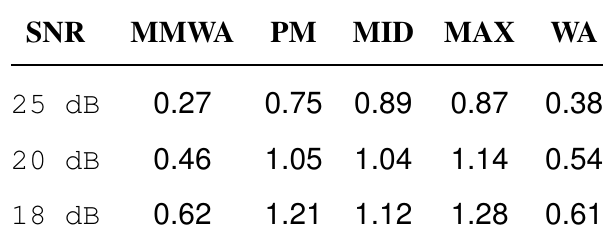
Table 2. Average RMS Error at different